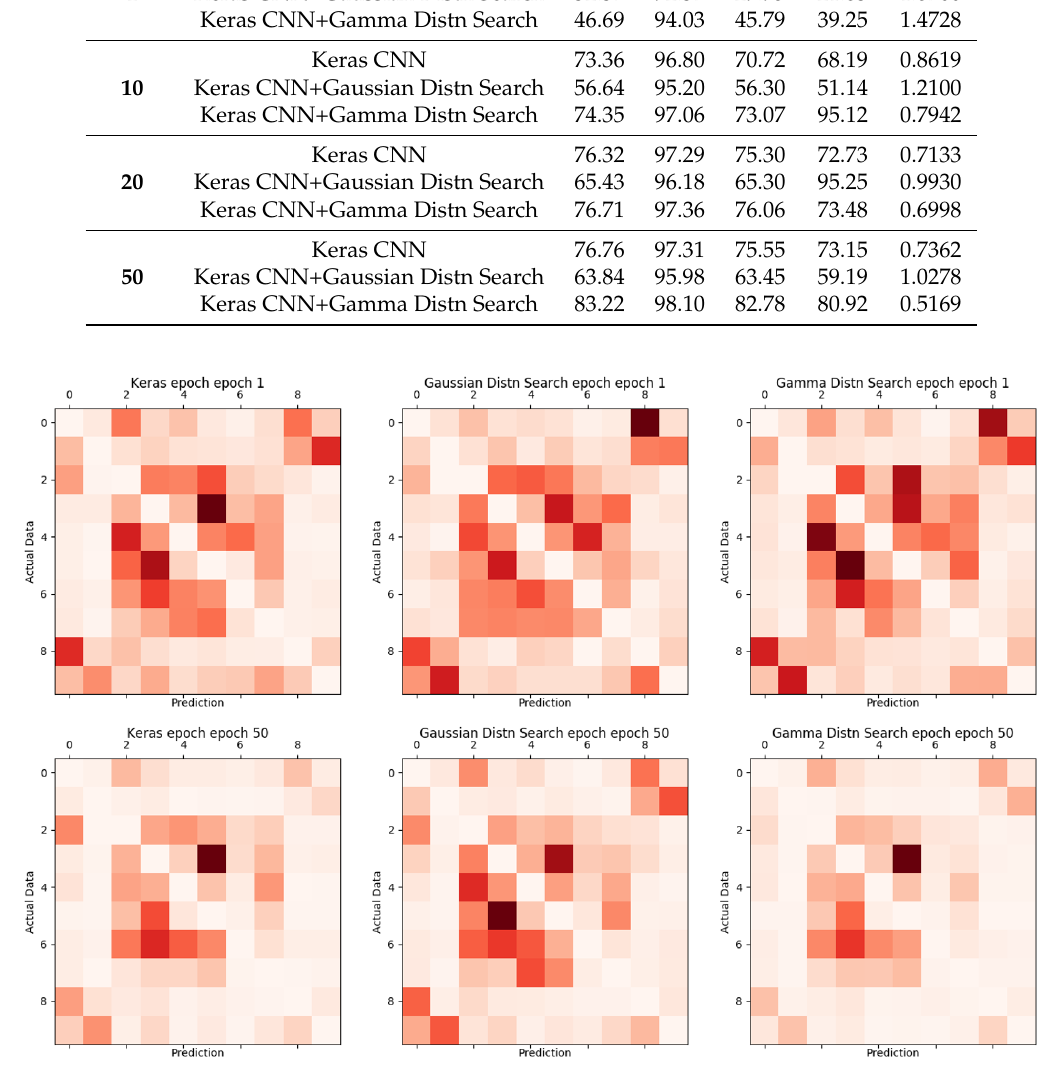
Figure 15. Proposed comparison of grid search, Gaussian distribution search, and Gamma distribution